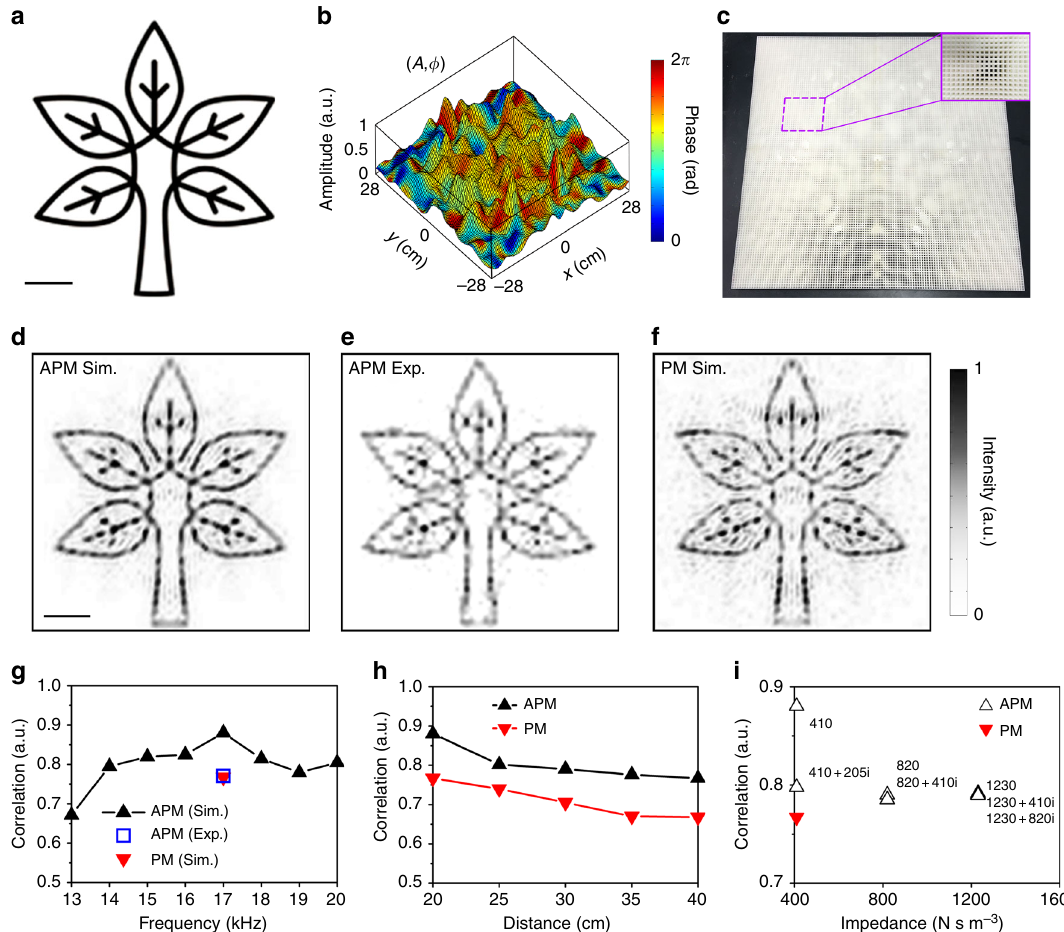
Fig. 5 Experimental veri fi cation of single-plane acoustic hologram. a The predesigned image of a tree. Scale bar, 10 cm. Rights for use of this image are from Dreamstime (www.dreamstime.com). All rights reserved. b Amplitude and phase pro fi les on the hologram plane for projecting the tree image. c The photograph of the 3D printed LAM sample. d , e The simulated holographic image by the APM method and the experimentally measured result. Scale bar, 10 cm. f The simulated holographic image by the PM method. g The correlation between the resulting image and the predesigned image at different frequencies from 13 to 20 kHz for APM, and at 17 kHz for PM. h The correlation between the resulting image and the predesigned image when the image plane locates at different distances. i The correlation between the resulting image and the predesigned image for different back